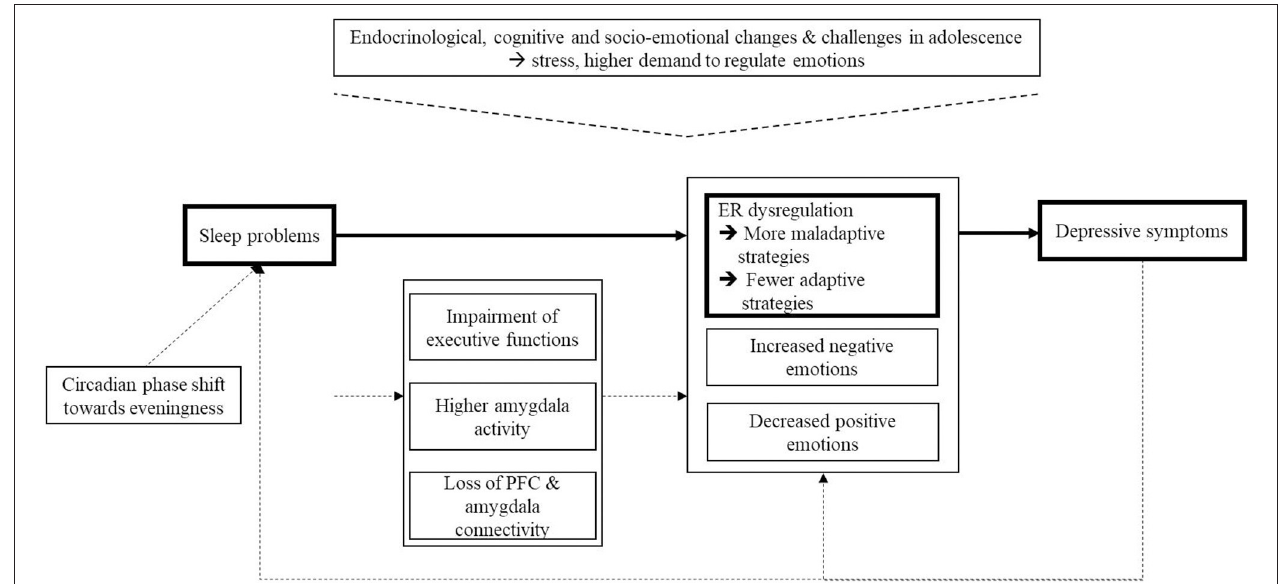
FIGURE 1 | Schematic overview of the assumed associations and possible underlying mechanisms which are discussed in the literature. Dash line, evidence of prior literature; Solid line, associations under examination in the present